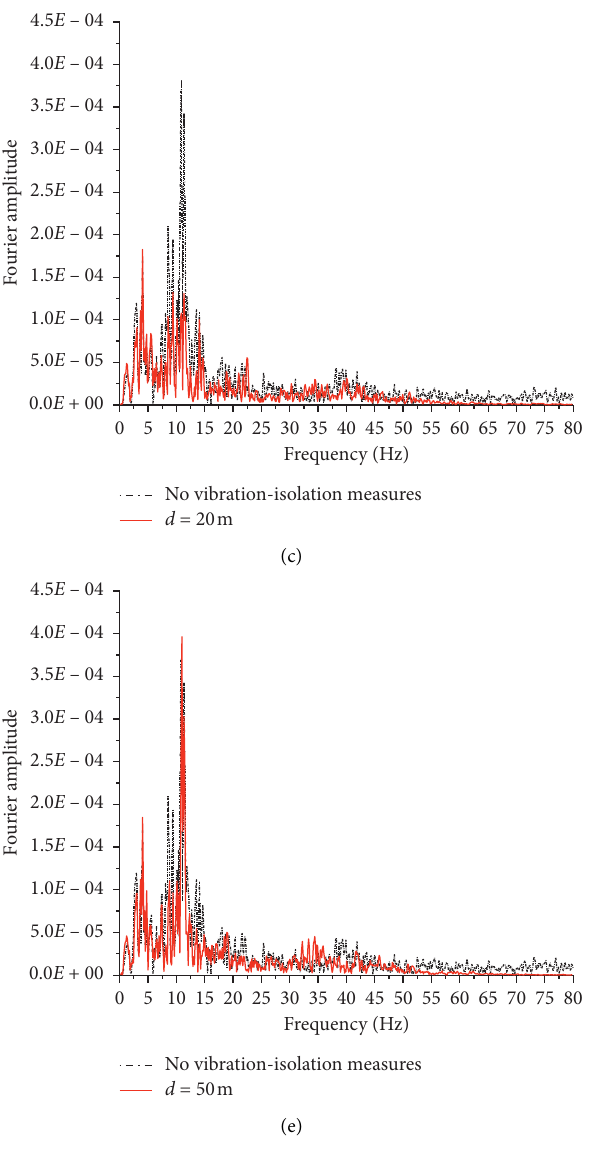
Figure 34: Influence of distance from hard-X-ray tunnel ( d ) on vibration-isolation effect (comparison of frequency